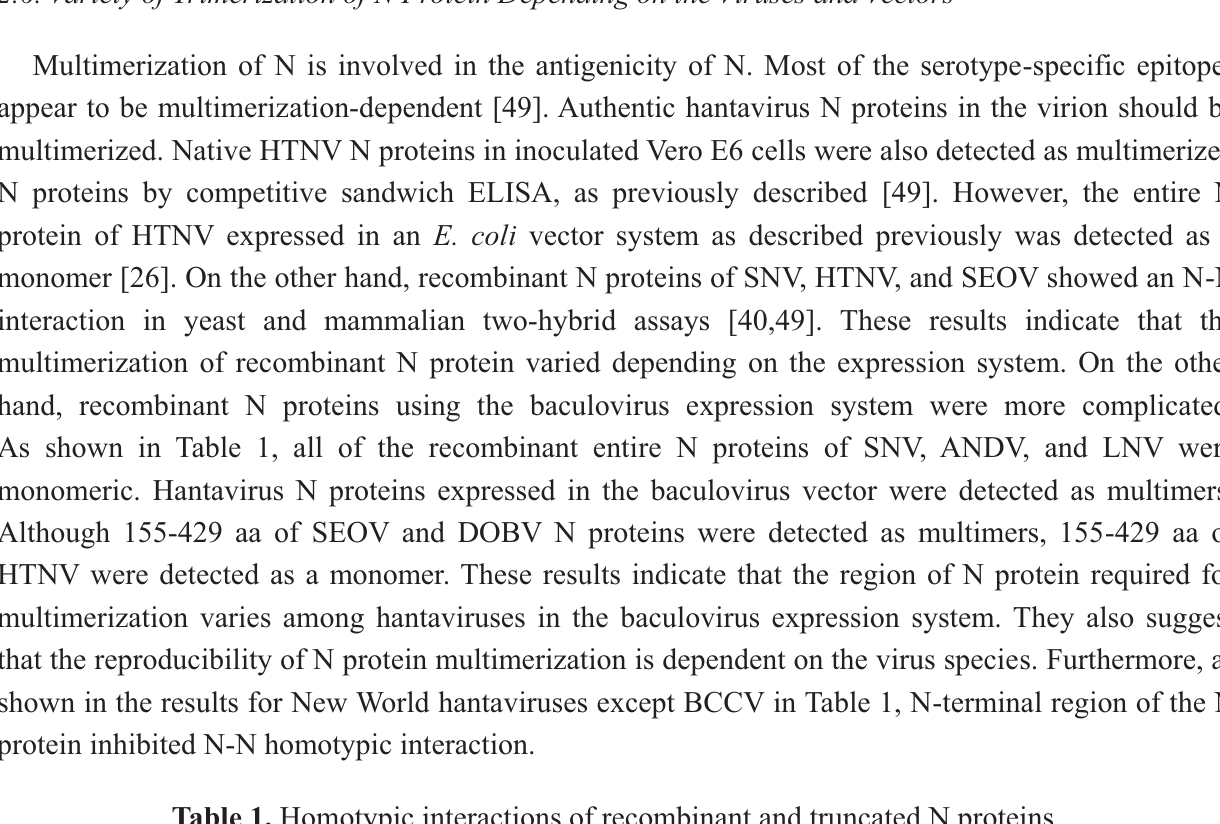
Table 1. Homotypic interactions of recombinant and truncated N